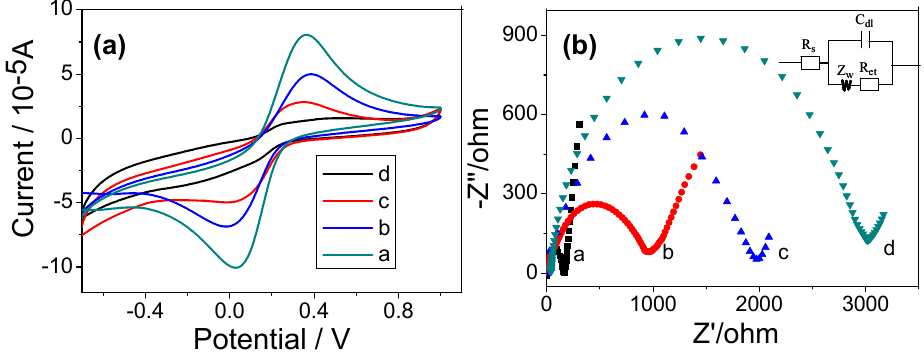
Figure 4. ( a ) Cyclic voltammograms and ( b ) Nyquist plots of impedance spectra at different electrodes in a solution of 1.0 × 10 − 2 mol · L − 1 phosphate-buffer solutions (PBS) (pH = 7.4) containing 2.0 × 10 − 3 mol · L − 1 K 3 Fe(CN) 6 -2.0 × 10 − 3 mol · L − 1 K 4 Fe(CN) 6 -0.1 mol · L − 1 KCl. Curve a, bare GCE; curve b, HG/ glass carbon electrode (GCE); curve c,d, HG/GCE after incubation with 5.0 × 10 2 cells · mL − 1 and 5.0 × 10 3 cells · mL − 1 for 40 min, respectively. Inset, displays the